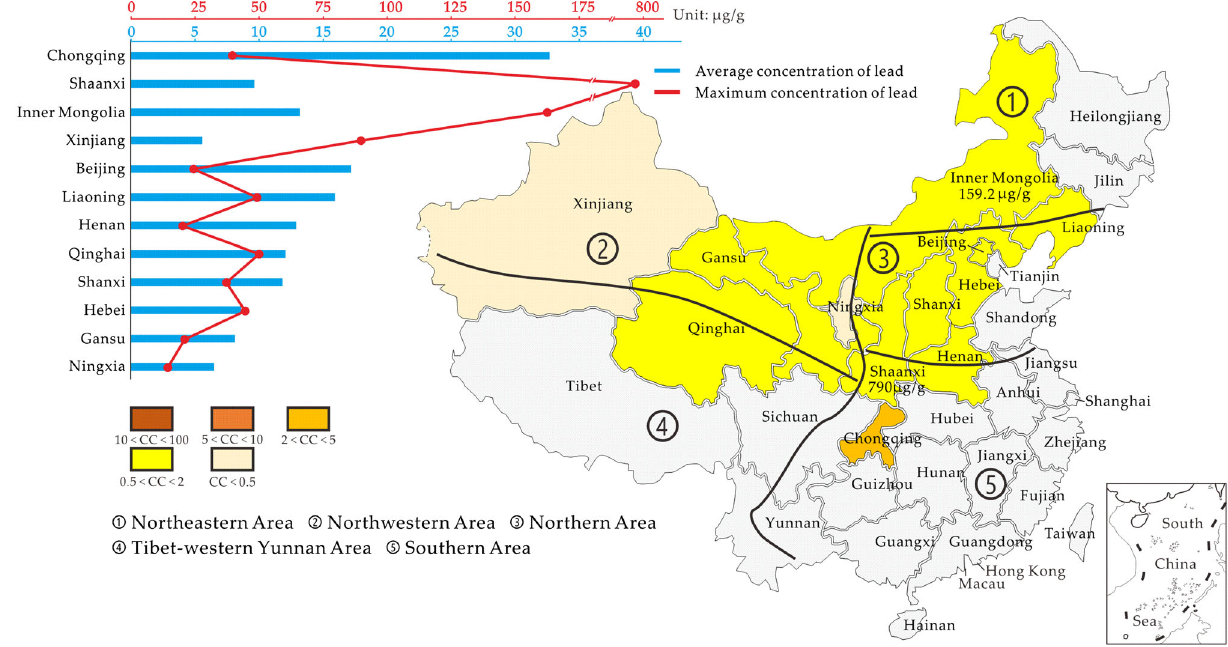
Fig. 5 Distribution of lead in Chinese coals from the Early to Middle Jurassic (J 1–2 ) period. CC: Concentration